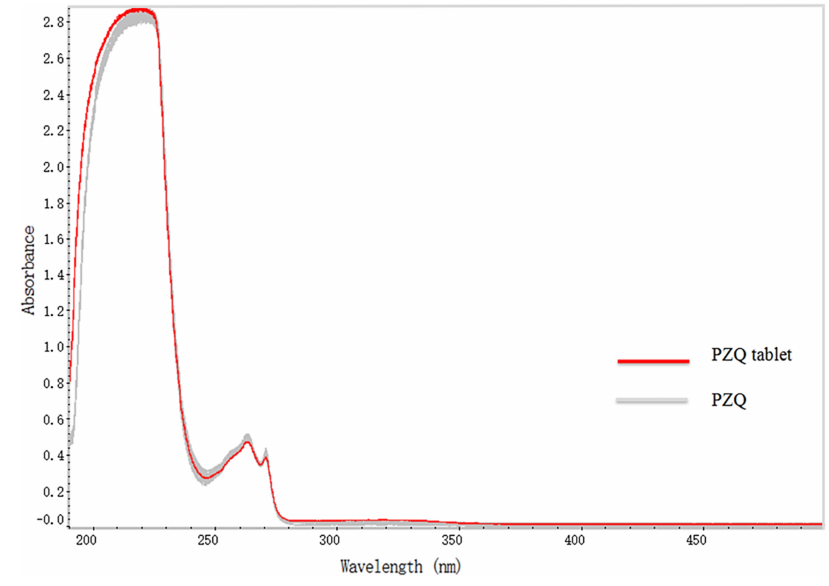
Fig. 5. The spectra of the six solutions of PZQ tablets. It had no abnormal phenomenon compared with the